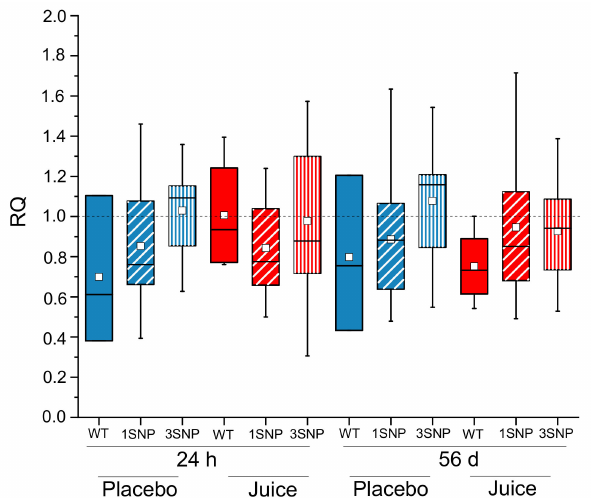
Figure 5. Modulation of the NFE2L2 transcript level in PBLs after short-term (24 h) and long-term (56 d) intake of anthocyanin-rich multi-fruit juice (Juice in red) or placebo beverage (Placebo in blue) in correlation to NFE2L2 promoter single nucleotide polymorphisms (SNPs). NFE2L2 transcript levels were normalized to ACTB and GAPDH and related to the control (levels at 0 h). Abbreviations: h: hours, d: day; WT = wild-type (without SNP); 1SNP = Nrf2 promoter SNP rs35352124; 3SNP =